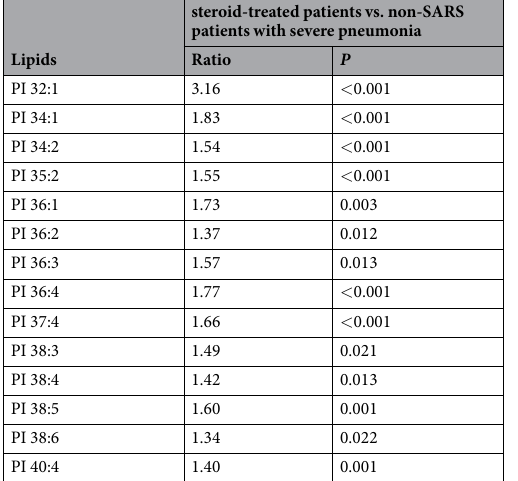
Table 3. Differential phosphatidylinositols in serum from steroid-treated non-SARS patients with severe pneumonia versus non-SARS patients with severe pneumonia without steroid